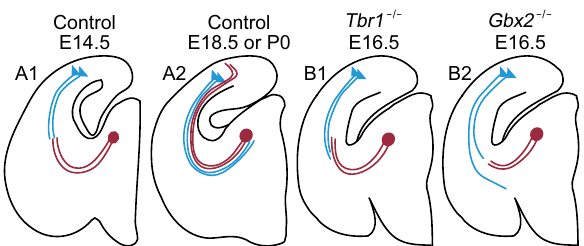
Figure 7. Schematics for handshake model and related guidance cues. (A1 – 2) Schematics for handshake model. (B1 – 2) Misled CT and TC axons after Tbr1 and Gbx2 genes knock- out. Blue triangles represent corticothalamic projecting neurons. Blue lines represent CT axons. Red dots represent thalamo- cortical projecting neurons. Red lines represent TC axons. CP: